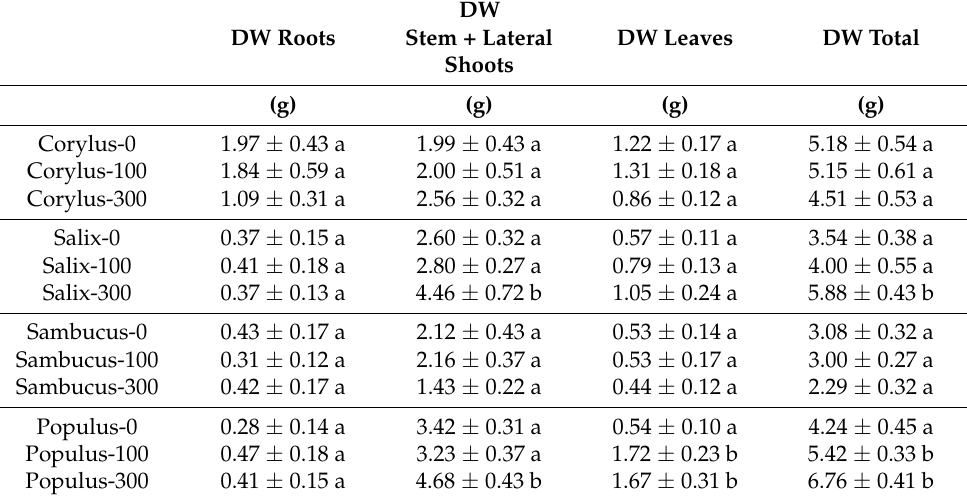
Table 3. Dry weight (DW) of different parts and total DW of plants of Corylus, Salix, Sambucus and Populus treated with the three NO 3 − concentrations in hydroponic nutrient solution at 21 days after the treatment (DAT).